Question: Is the quantity shown trending increasing or decreasing?
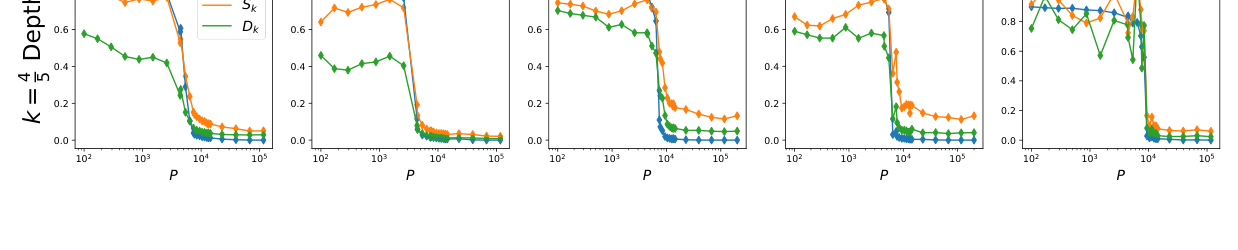
Answer: increasing